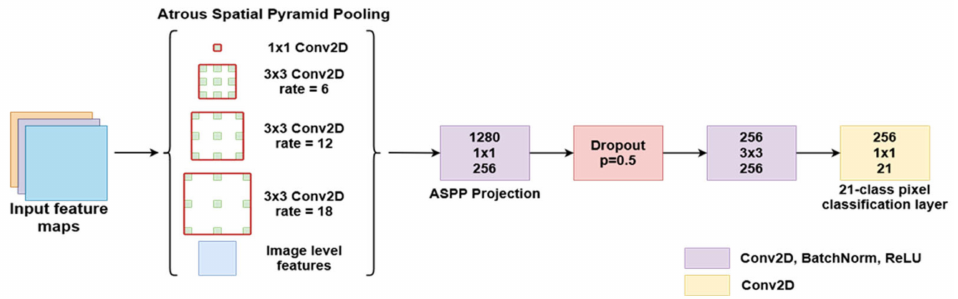
Figure 5. DeepLabV3 segmentation